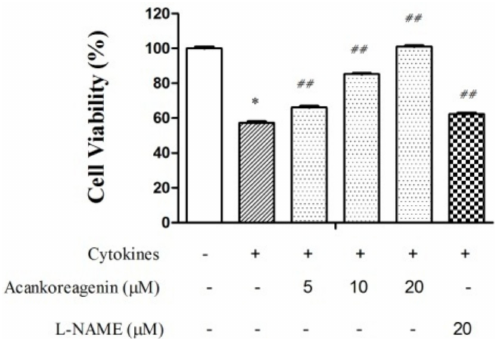
Figure 5. Effects of acankoreagenin on the cytokine-induced cell death in the RIN-m5F cells. The RIN-m5F cells were pretreated with the indicated concentrations of samples for 1 h and then IL-1 β (10 ng/mL) and IFN- γ (100 ng/mL) were added. Cell viability was determined using the MTT assay. * p < 0.05 versus vehicle-treated control; ## p < 0.01 versus cytokine-treated group. Bars indicate SEM ( n =